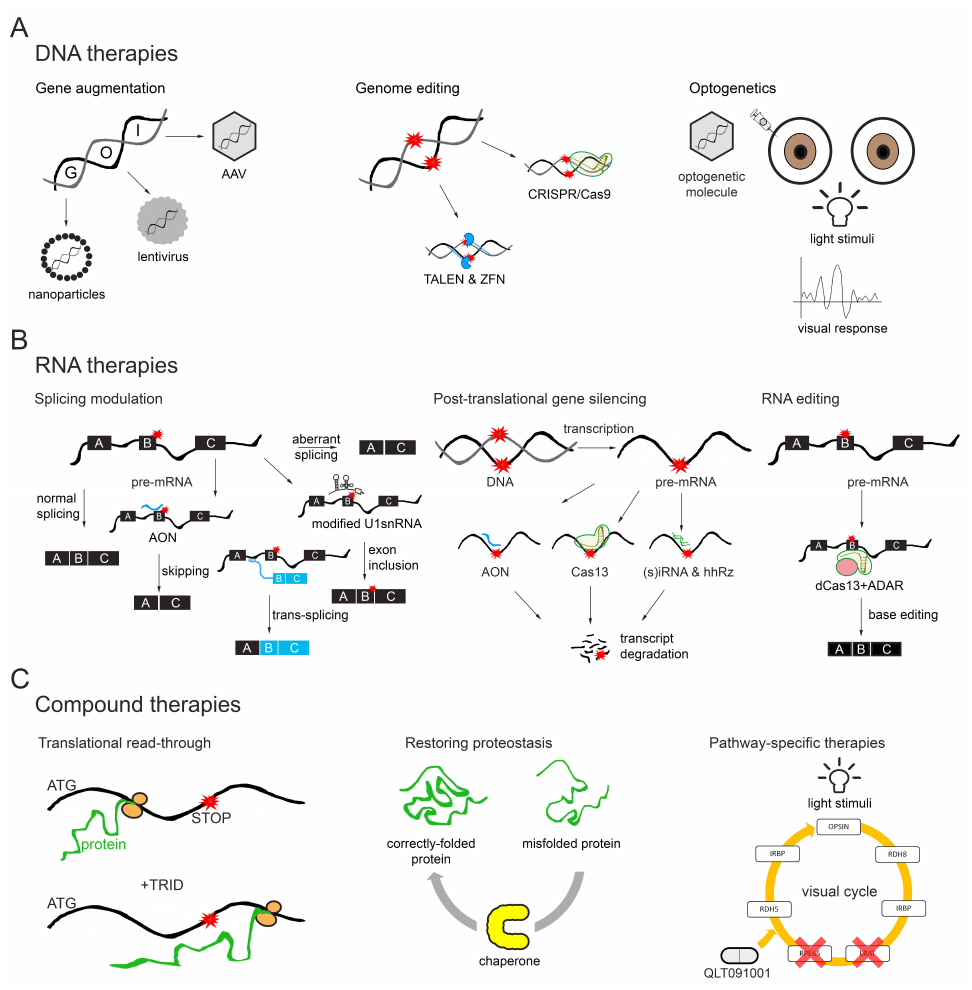
Figure 2. Schematic and simplified representation of the several types of molecular therapies. ( A ) DNA therapies are represented by gene augmentation, genome editing and optogenetics. In gene augmentation, the entire coding sequence of the gene of interest (GOI) is delivered using di ff erent vectors. Genome editing employs nucleases able to edit the DNA at a specific position; CRISPR / Cas9 is depicted in green, guide RNA in dark yellow and ZFN and TALEN in blue. Mutations are depicted in red. In optogenetics, a light-sensitive molecule is delivered to the eye to give photosensitive properties to remaining retinal neurons. ( B ) RNA therapies; splicing modulation can be achieved using AONs (in dark blue) for (pseudo)exon skipping or modified U1 snRNA (in black) to favour exon inclusion in cases where mutations (in red) are found in the donor splice site. Trans-splicing occurs between two independent RNA molecules—The original transcript and the exogenous molecule without the mutation. In all cases, splicing is modulated to obtain a transcript with full or residual function. Post-translational gene silencing can be achieved by degrading the RNA transcript using AONs (dark blue), Cas13 (green) with a guide RNA (dark yellow) or (s)iRNA and hhRz (in green). These approaches can be used for dominant-negative mutations by promoting allele-specific degradation. Mutations are indicated in red. With RNA editing using CRISPR / Cas technology, dead Cas13 (in green) is conjugated with an adenosine deaminase (dark yellow) acting at the RNA level (ADAR, in light red). This molecule is guided to the mutation using a guide RNA binding on top of the mutation (in red) to induce a G-to-A transversion. ( C ) Representative examples of compound therapies. Translational read-through allows the ribosome to continue protein synthesis despite a premature stop codon (in red) in the presence of the translational read-through-inducing drugs (TRIDs). Restoring proteostasis can be accomplished by using chaperones to properly fold proteins. QLT091001 is a pathway-specific therapy that acts in the visual cycle and can be used when for example, RPE65 or LRAT are